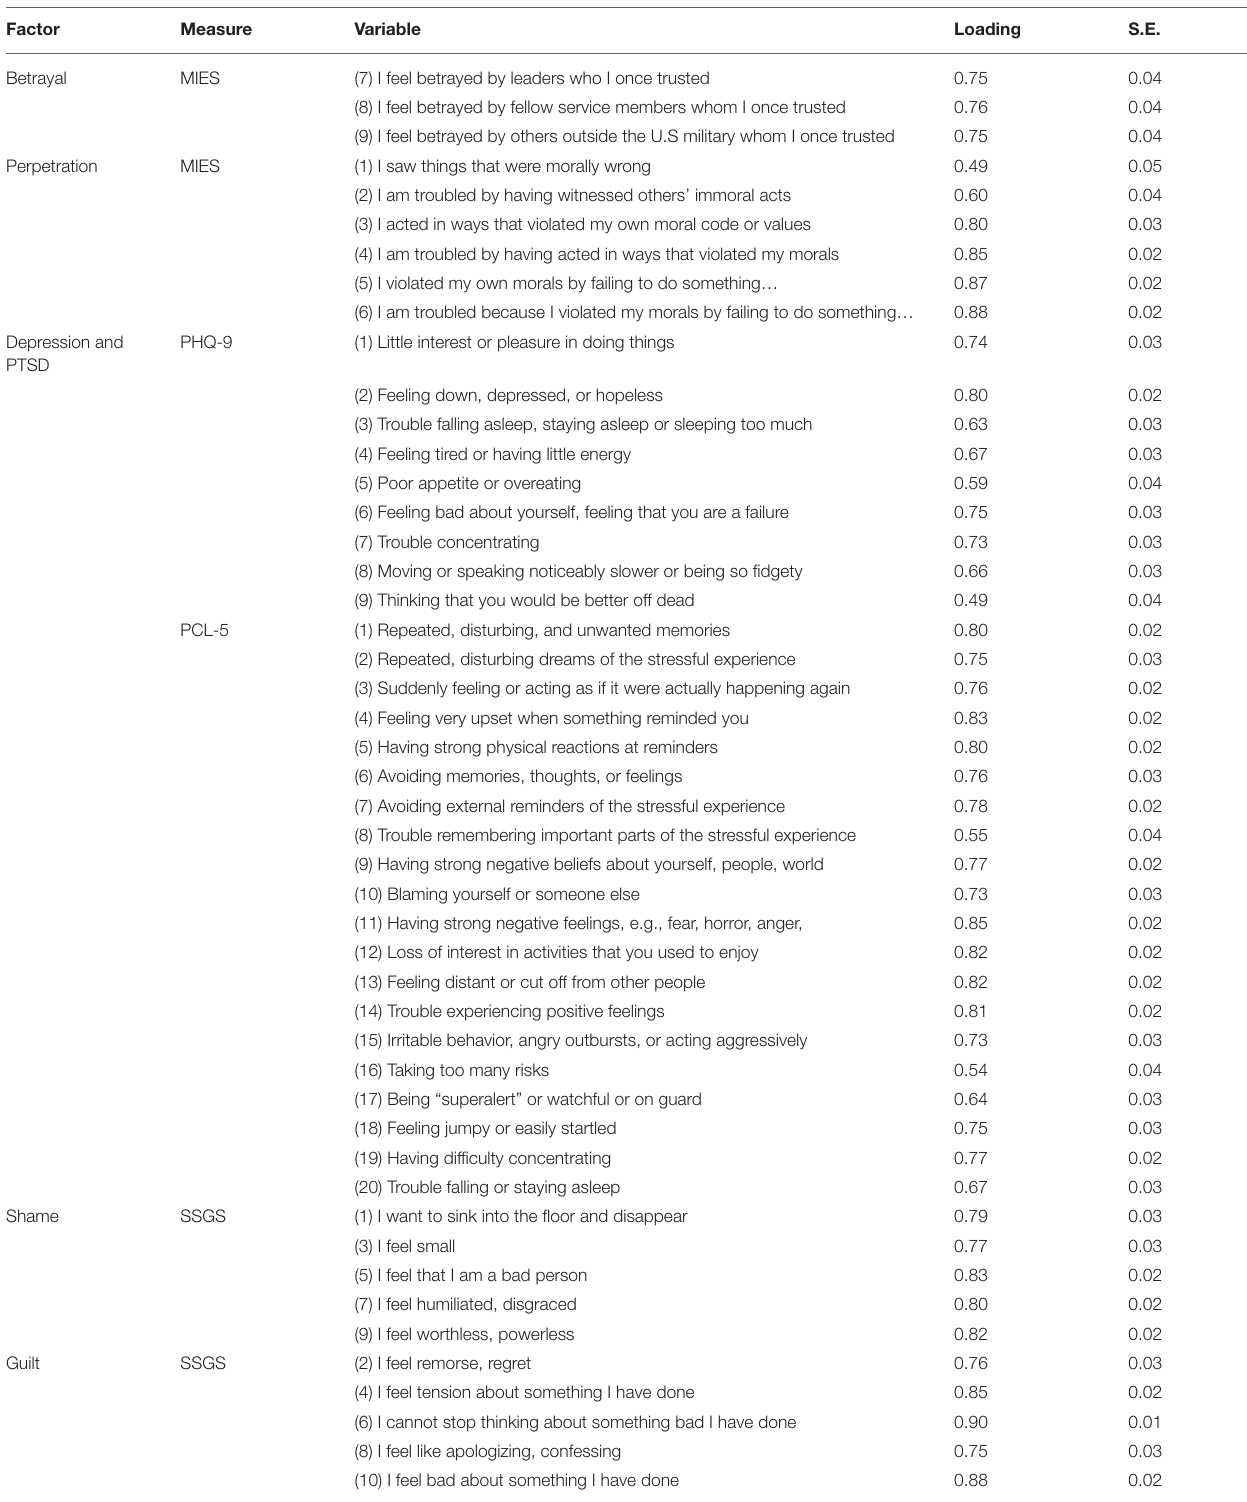
TABLE 2 | Factor loadings of measurement